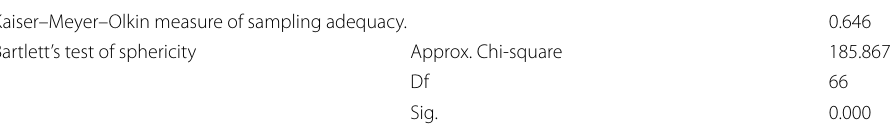
Table 12 KMO and Bartlett’s test (Post-DeMo, Panchmahal) Kaiser–Meyer–Olkin measure of sampling